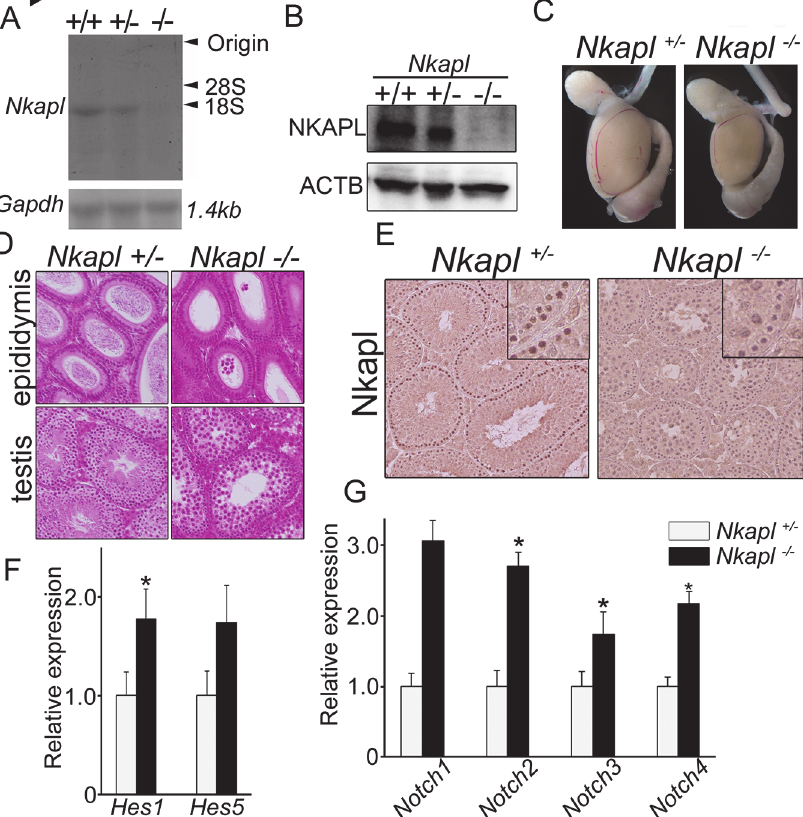
Fig 5. NKAPL deletion caused complete maturation arrest at meiosis through elevation of the Notch signaling pathway. (A) Nkapl mRNA transcription in testis of genetically modified mice by Northern blotting. (B) NKAPL expression in testis of genetically modified mice by immunoblotting. (C) Macroscopic appearances of testes in Nkapl+/- and Nkapl-/- mice. (D) Histology of testis and epididymis stained with hematoxylin and eosin. (E) Immunohistochemistry of Nkapl antibody for testes of Nkapl+/- and Nkapl-/- mice. (F) Transcriptional changes of Hes1 and Hes5 between testes of Nkapl+/- and Nkapl-/- mice by qRT-PCR. (G) Transcriptional changes of Notch1 to 4 . Error bars indicate standard deviation from the means. * P <